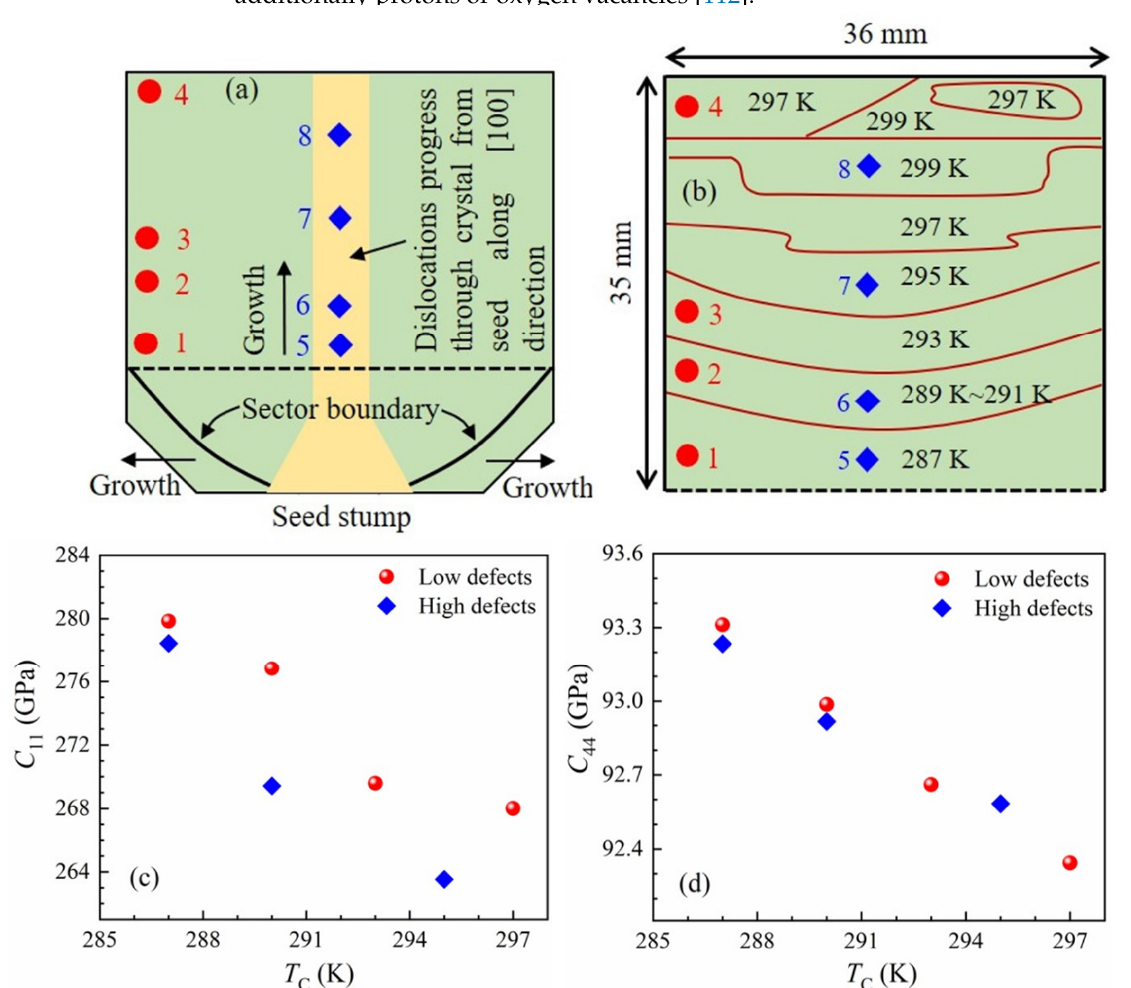
Figure 9. Schematic illustration of ( a ) spatial heterogeneity and ( b ) spatial dependence of T C in a composition gradient on Li-doped KTN wafer. Diamonds (blue) and closed circles (red) denote the regions with high and low defect density, respectively. The elastic constants ( c ) C 11 and ( d ) C 44 of a composition gradient Li-doped KTN wafer as a function of position. The data were adapted from Refs.